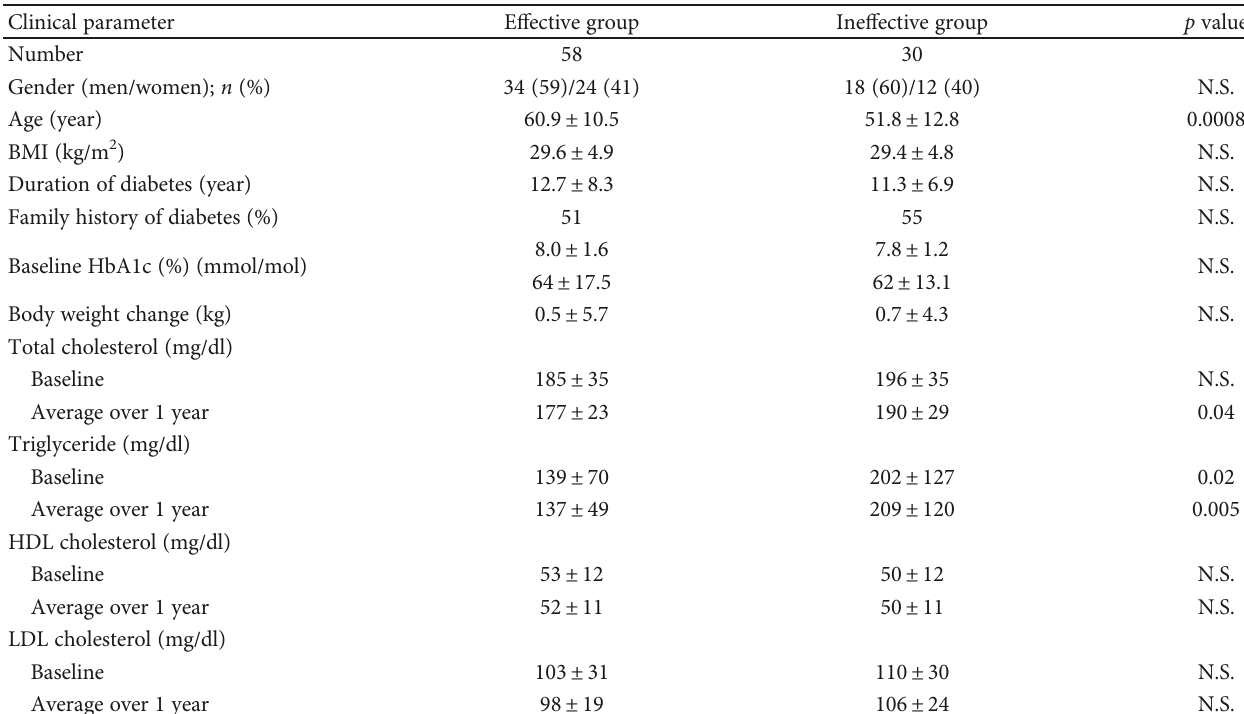
Table 4: Comparison of clinical background between the e ff ective group and ine ff ective group in obese subjects with type 2 diabetes (BMI ≥ 25kg/m 2